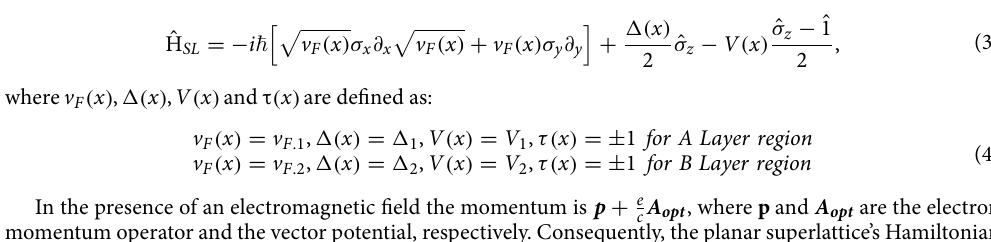
bands splitting. These separated sub-bands have up- and down-spin characteristics (see Fig. 1a). The lack of spin degeneracy together with time reversal symmetry is the reason of the intrinsic coupling between valley and spin degrees of freedom in valence sub-bands of ML-TMDCs. Therefore, interband transitions at two valleys are allowed only for optical excitations with opposite circular polarization. In the other words, K and K ′ val- e RHS ) and left -circular ( e LHS ) polarizations, respectively (Fig. 1). These leys are excited only by right -circular ( principles are not established for the bilayer configurations due to inversion symmetry and consequently the (cid:31) (cid:31) spin degeneracy in the valleys 24 . According to the Sturm–Liouville theorem as well as the hermeticity of the superlattice Hamiltonian 25 , we define the Hamiltonian for the whole structure as: